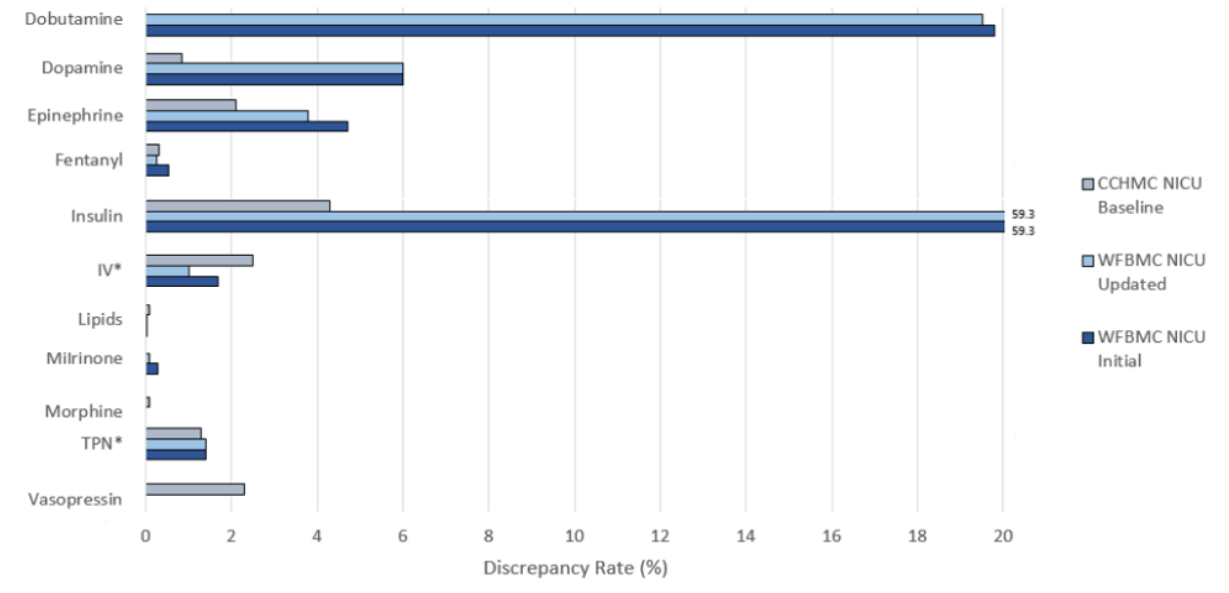
Figure 8. A comparison of discrepancy rates between (A) CCHMC NICU, (B) WFBMC NICU using the updated MED.Safe, and (C) WFBMC using the original MED.Safe. CCHMC: Cincinnati Children’s Hospital Medical Center; IV: intravenous; NICU: neonatal intensive care unit; TPN: total parenteral nutrition; WFBMC: Wake Forest Baptist Medical Center.